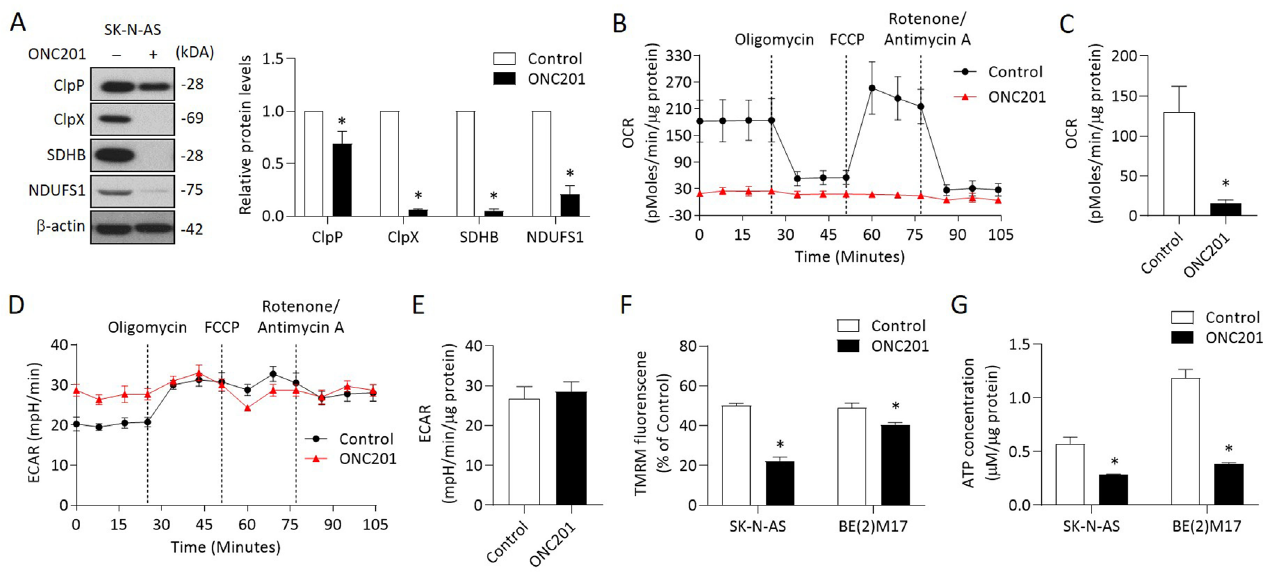
Figure 3. Effects of ONC201 on mitochondrial functions in NB cells: ( A ) The relative protein levels of ClpP, ClpX, SDHB, and NDUFS1 were determined by Western blot and quantified by Image Pro-plus analysis software. ( B , C ) OCR in ONC201-treated cells were detected by the Seahorse XF24 analyzer in the absence or presence of oligomycin (1 µ M), FCCP (0.5 µ M), and rotenone (1 µ M) by counting 1 × 10 5 cells. ( D , E ) Profiling of ECAR in control and ONC201-treated cells was measured by the Seahorse XF24 analyzer. ( F ) Cells were labeled with TMRM (100 nM) to examine mitochondrial membrane potential and analyzed by flow cytometry. ( G ) Total cellular ATP levels were measured using the luciferase-based luminescence assay kit. All data were obtained from three independent experiments, and are expressed as mean ± SD. * p <